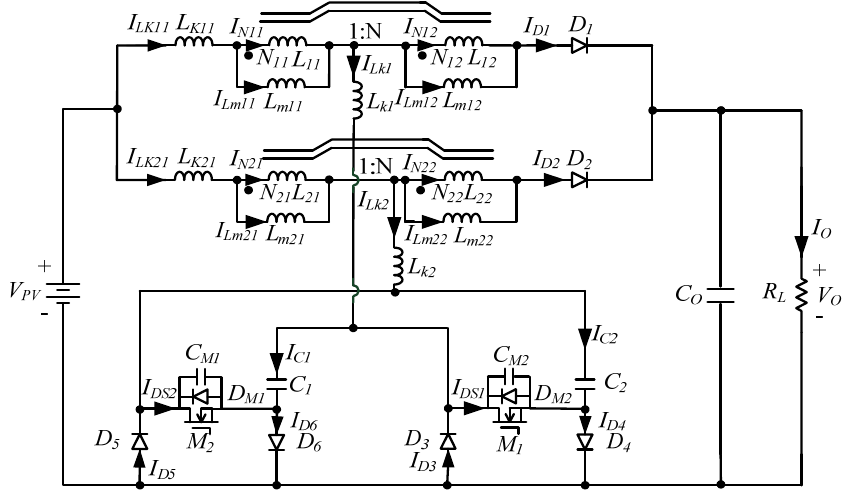
Figure 4. Schematic diagram of the proposed interleaved active clamp boost converter with coupled